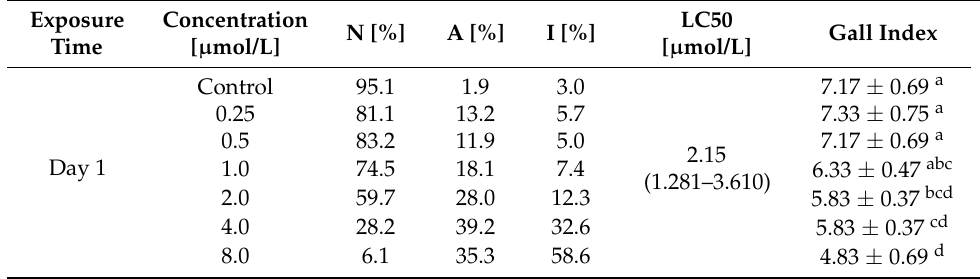
Table 1. In vitro effect of different concentrations of fluopyram on Meloidogyne incognita second-stage juveniles (J2s) after 1, 2, 3 and 14 days of exposure and recovery assay using Cucumis sativus root systems as bio